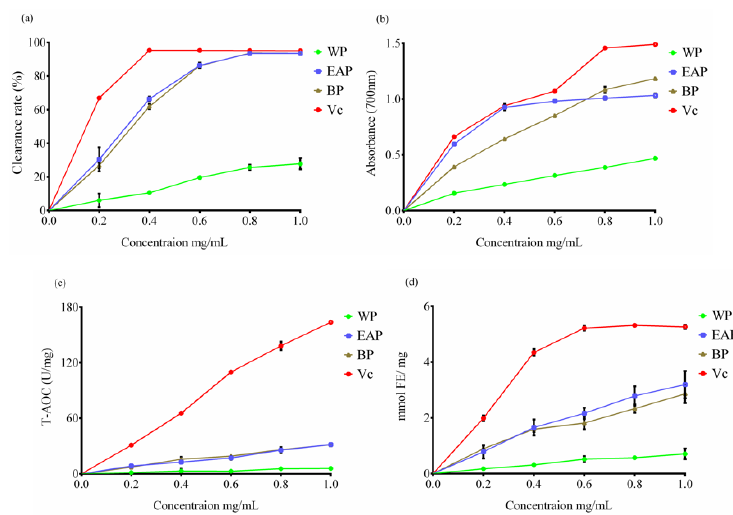
Figure 2. The antioxidant ability of three phases ( a ) 2,2-Diphenyl-1-picryl-hydrazyl (DPPH) free radical scavenging capacity, ( b ) total reduction capacity, ( c ) total antioxidant capacity (T-AOC) and ( d ) ferric ion reducing antioxidant power (FRAP).